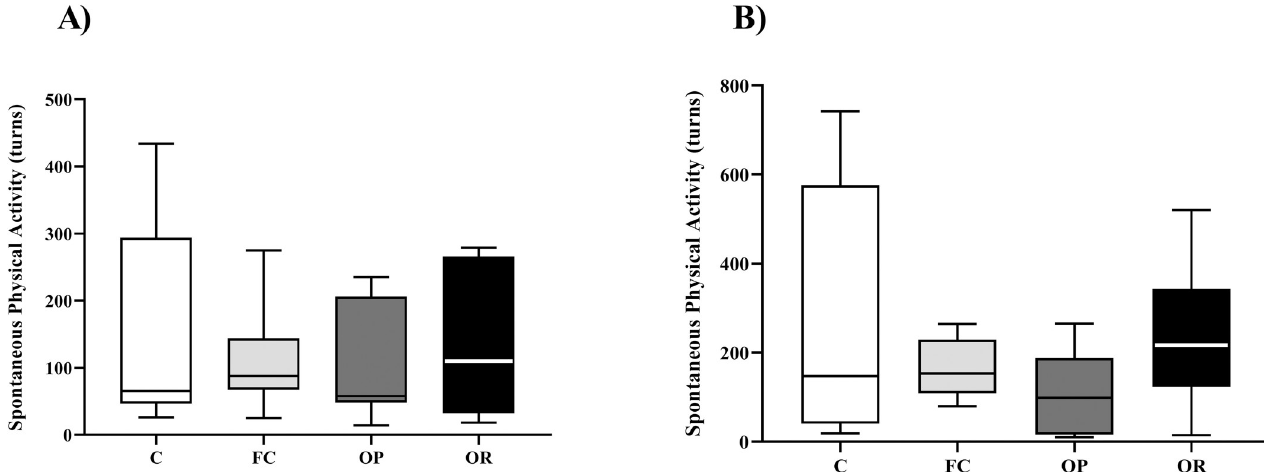
Fig 4. Voluntary physical activity counts measured in weeks 4 and 8. A) Turns performed at time 1 for 7 consecutive hours, Control (C, n = 6), false-control (FC, n = 8); obese-prone (OP, n = 7) and obese-resistant (OR, n = 8); B) Rotations performed at the moment and for 4 consecutive hours, Control (C, n = 8), false control (FC, n = 6); obesity-prone (OP, n = 8) and obesity-resistant (OR, n = 8). Data are expressed in median and quartiles. One-way non-parametric ANOVA (Kruskal-Wallis) complemented with Dunn’s post-hoc test.